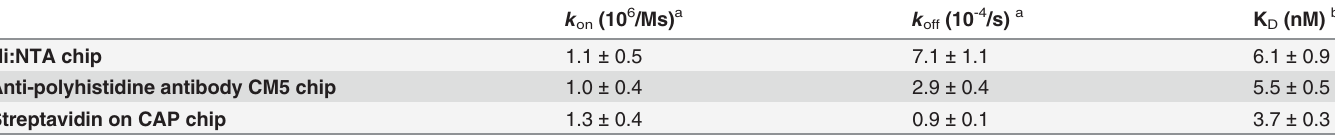
Table 1. Determination of the kinetic parameters k on and k off and affinities K D of the GFP:GFP-Nb interaction on different biosensor chip surfaces.